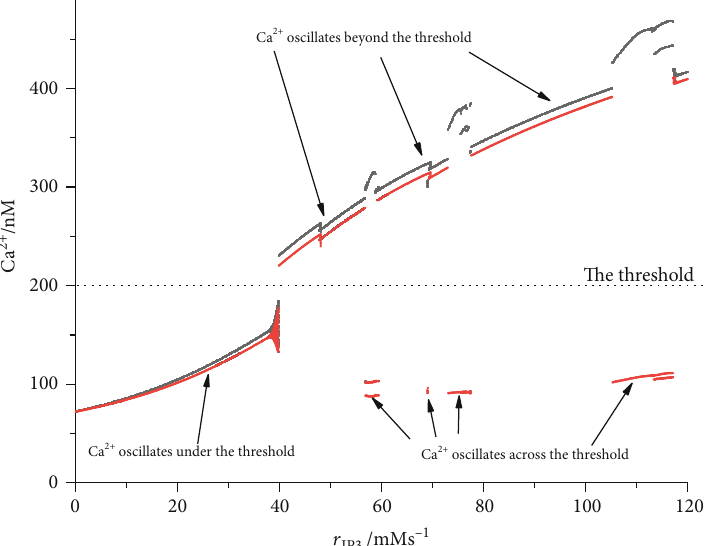
Figure 3: Crests and troughs of the oscillation of Ca 2+ concentration respect to r the oscillation. The dashed line means the